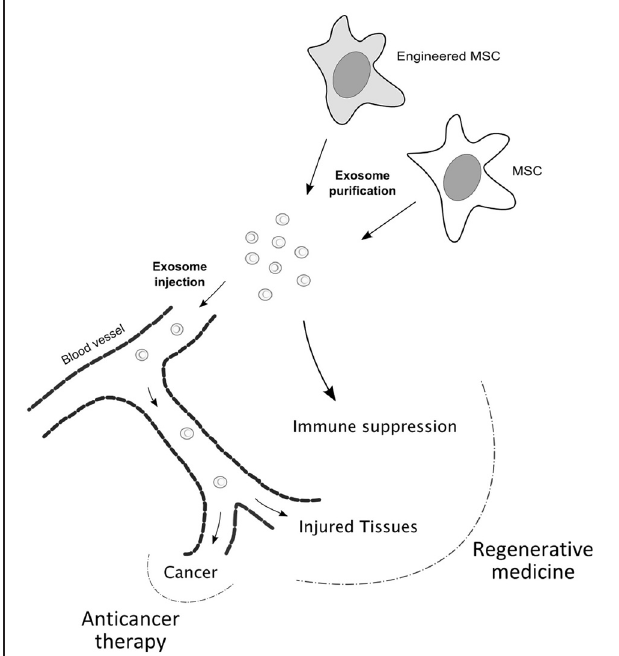
FIGURE 3 | Proposed model for therapeutic applications of MSC-derived exosomes. MSC-derived exosomes may be used instead of MSCs in regenerative medicine and anticancer therapy, since they seem to hold the beneficial properties of the parental cells. MSC-derived exosomes might retain the homing ability displayed by MSCs towards sites of inflammation and function in tissue repair, also by modulating the immune response. Concerning anticancer therapy, exosomes derived from engineered MSCs might be used to mediate anti-proliferative or pro-apoptotic effects. Moreover, whenever the tropism of exosomes would not be retained, MSCs may be modified to confer specific targeting to